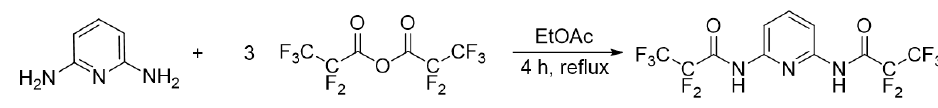
Figure 2. Synthesis of PFPAP.